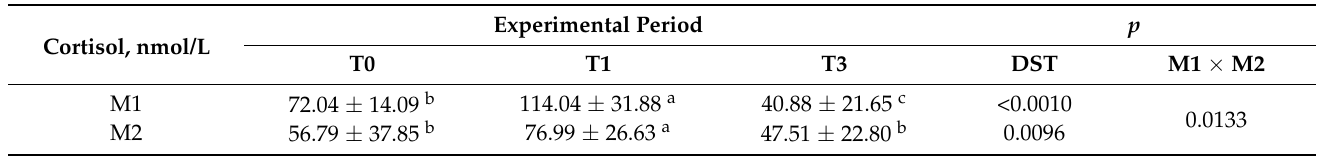
Table 2. Cortisol (nmol/L) measured in the dressage simulation tests used to evaluate a 6-week training protocol for Lusitano horses.